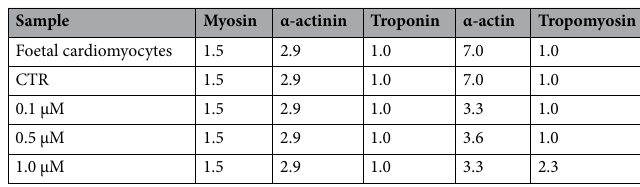
Table 1. Sarcomeric protein ratio referred to Troponin (set at 1) of foetal, CTR and ATO-exposed cardiomyocytes.